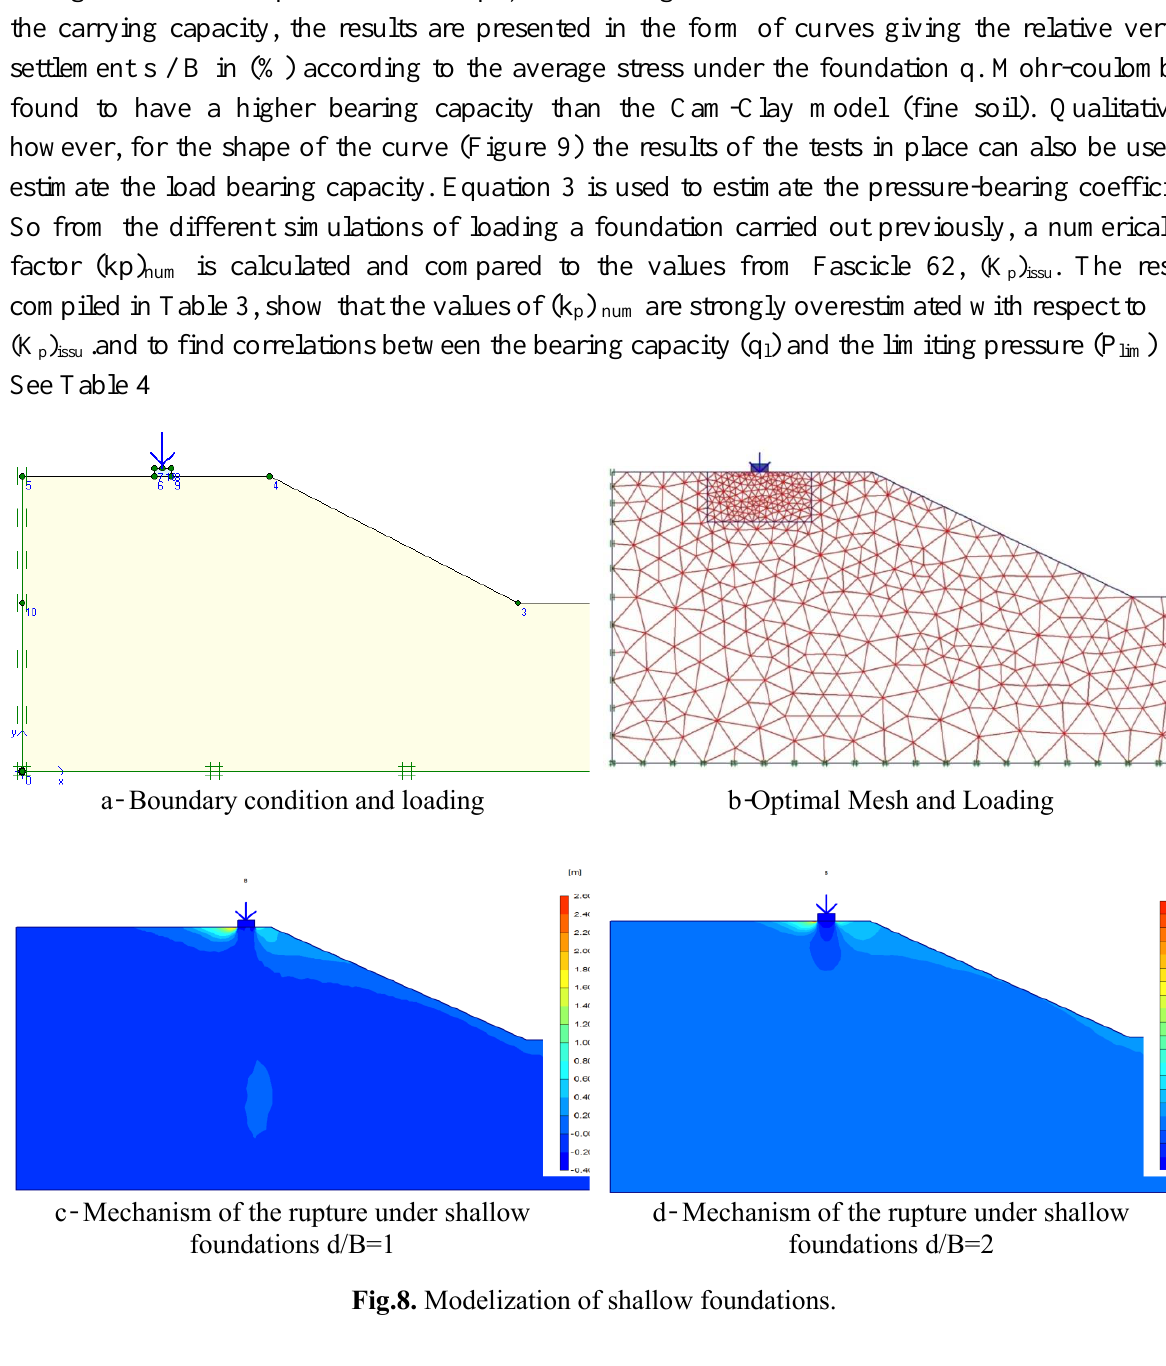
Fig.8. Modelization of shallow